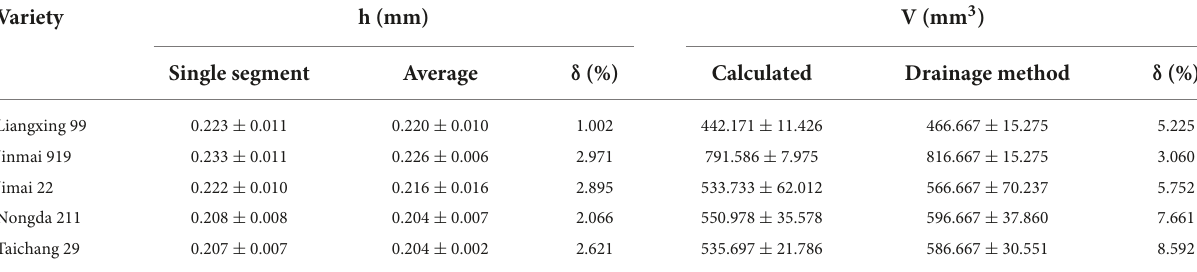
TABLE 1 Leaf thickness from a single segment compared with the average of 20 segments and calculated leaf volume compared to volume measured with the drainage method. Variety